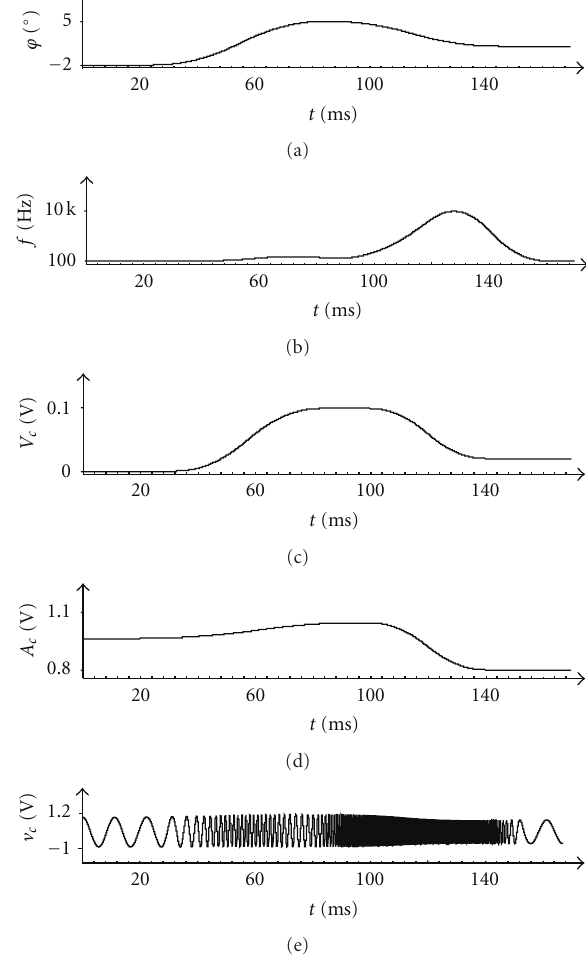
Figure 7: Input signal-time waveform v c ( t ) and its parameters’ time waveforms: ϕ ( t ), f ( t ), V c ( t ), A c ( t